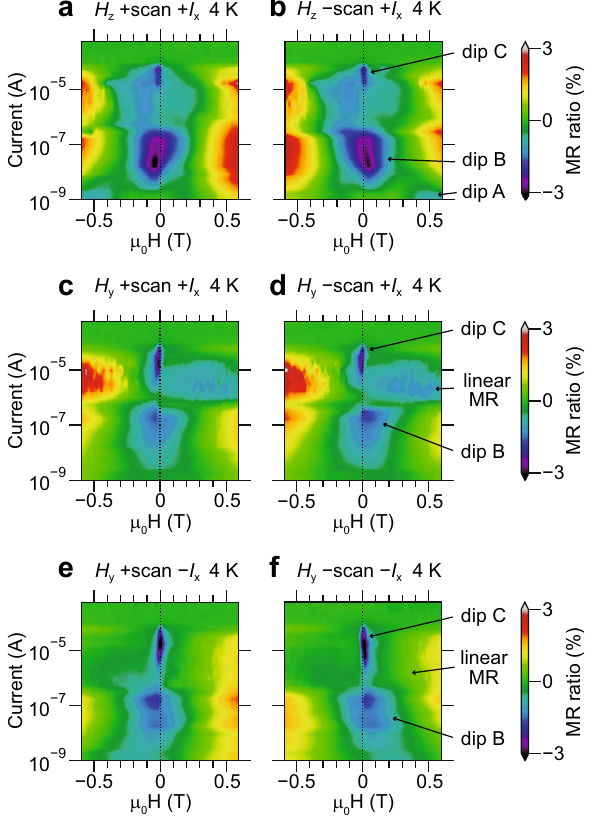
Figure 4. Colour-coded map of magnetoresistance measured with various currents at 4 K. ( a , b ) Magnetoresistance as functions of current and magnetic field applied along the out-of-plane direction ( H z ). ( c–f ) Magnetoresistance as functions of current and magnetic field applied along the in-plane direction crossing the current ( H y ). The current directions are + I x ( a – d ) and − I x ( e , f ). The magnetic field is swept from positive to negative (+ scan) ( a , c , d ) and from negative to positive (− scan) ( b , d , f